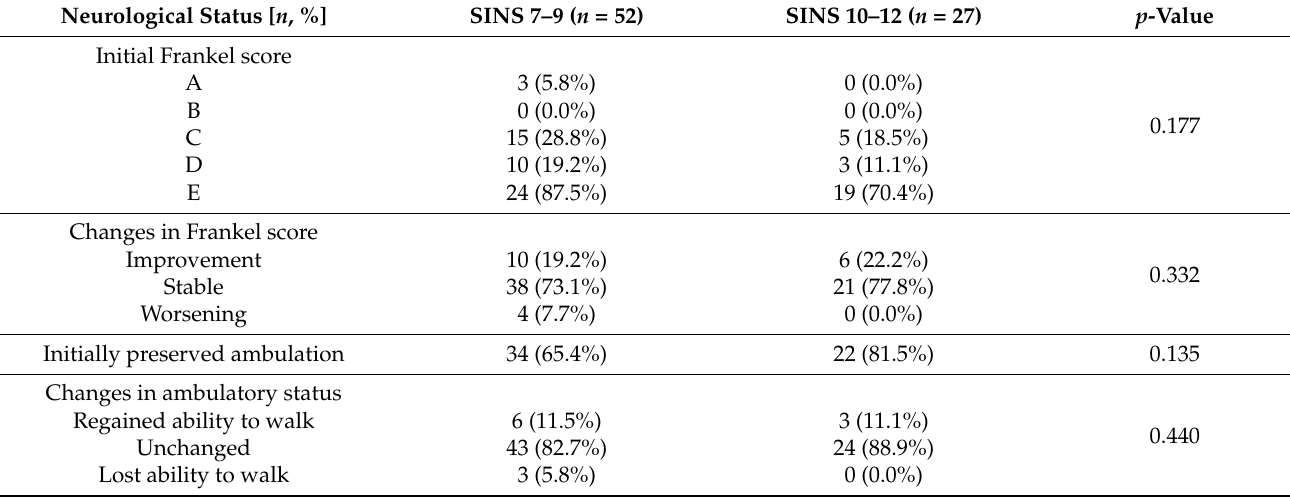
Table A7. Frankel score and ambulatory status in all non-instrumented patients with SINS 7 to 9 and SINS 10 to